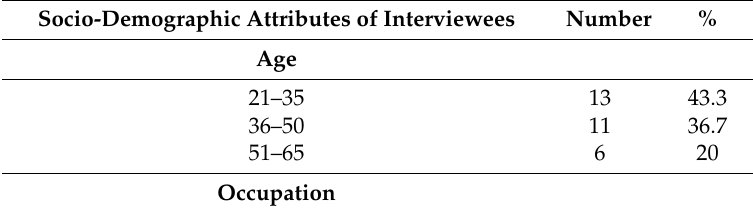
Table 1. The profile of the focus group